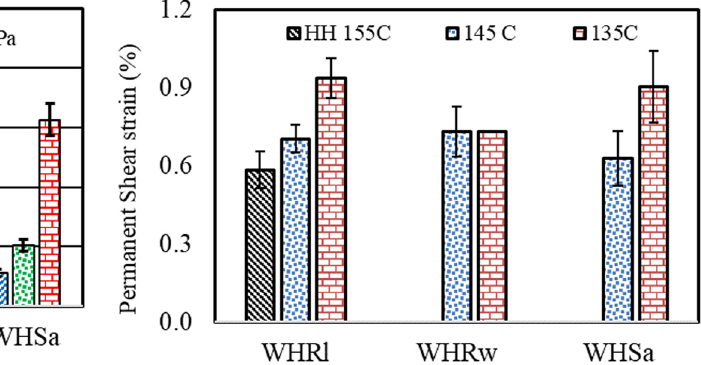
Figure 12: Final permanent shear strain at the termination of the MSCR test.